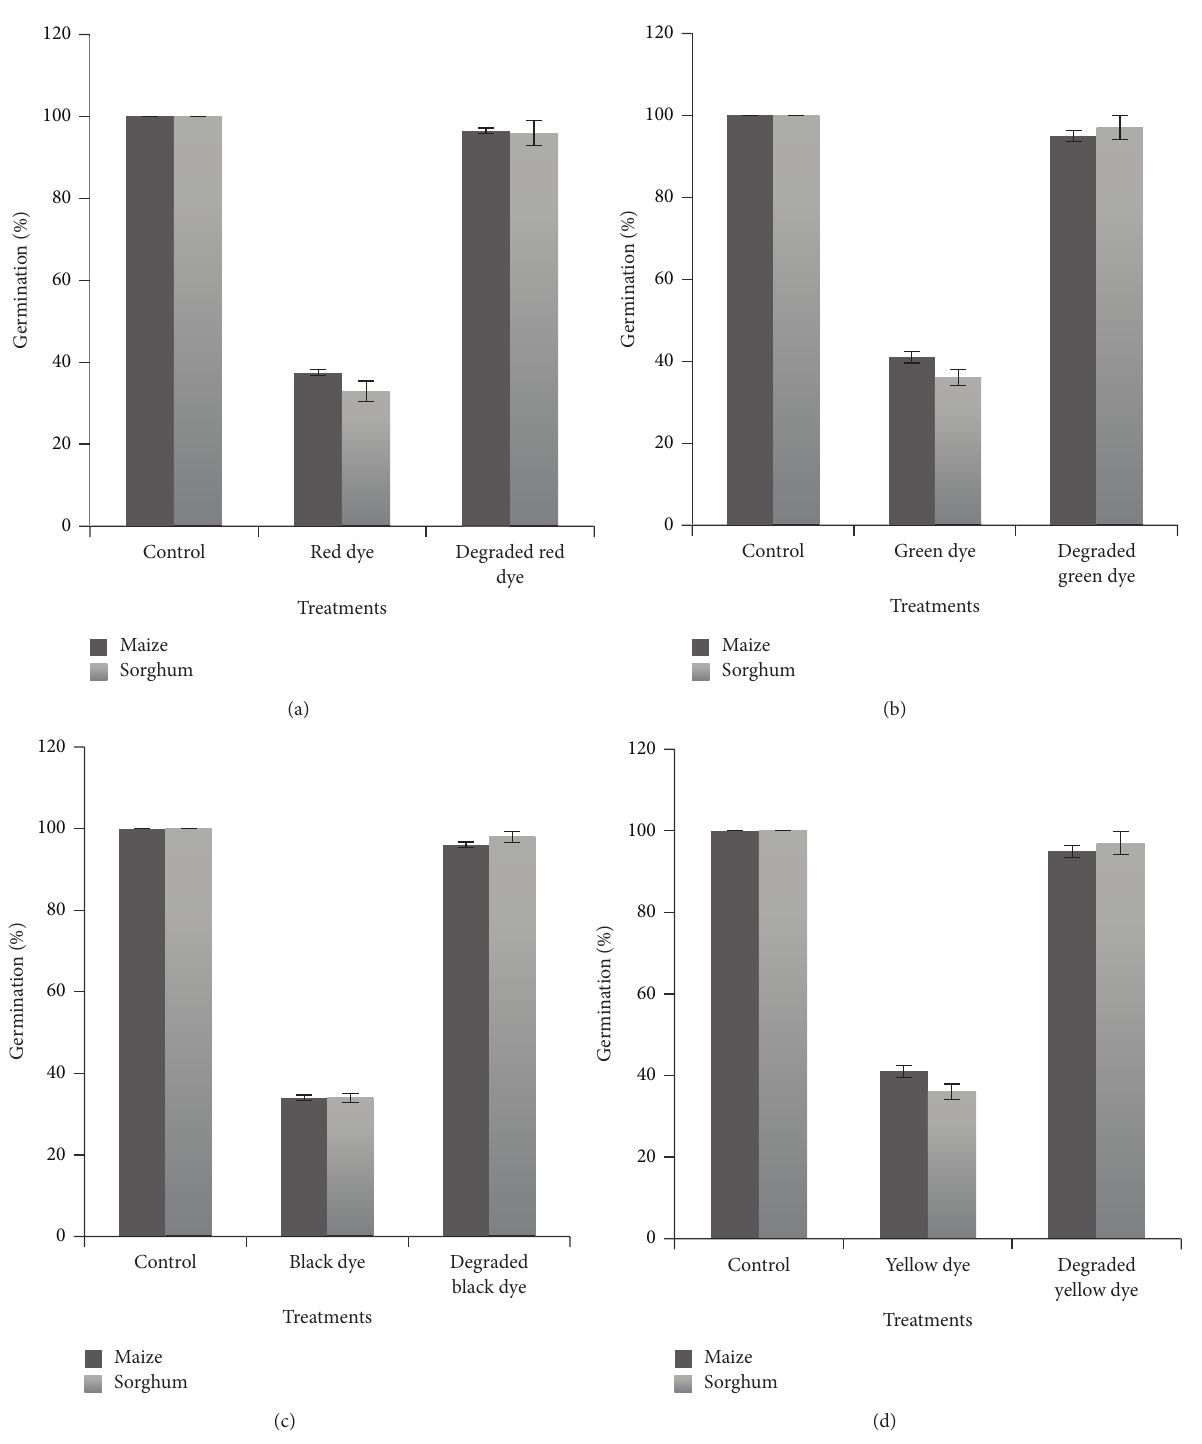
Figure 2: Effects of textile dyes: red (a), green (b), black (c), and yellow (d) before and after the degradation on germination of maize and